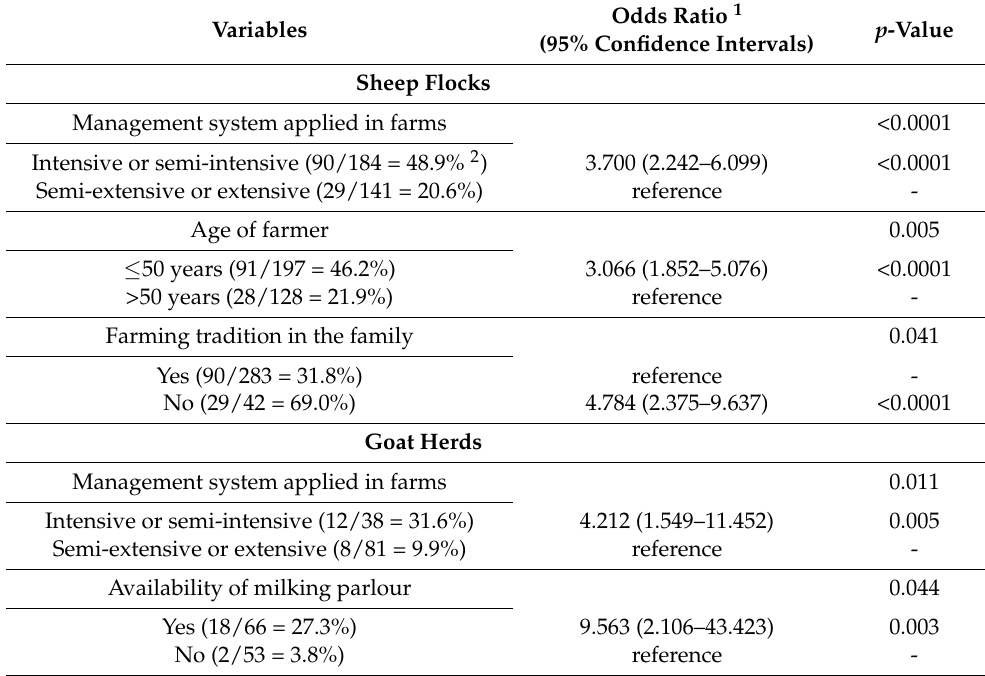
Table 2. Multivariable analysis for predictors for pregnancy diagnosis by means of ultrasonographic examination in sheep and goat farms in